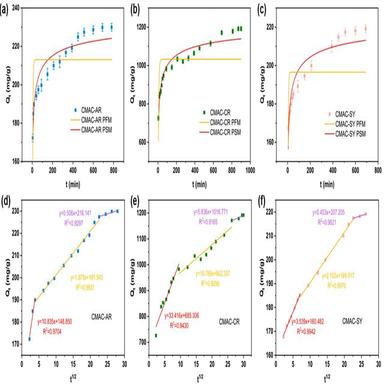
Kinetics of AR, CR and SY adsorption on CMAC at 298 K, actual pH and 300 rpm of stirring. (a-c) Pseudo–first order and pseudo–second order kinetic model and (d-f) intraparticle diffusion model.